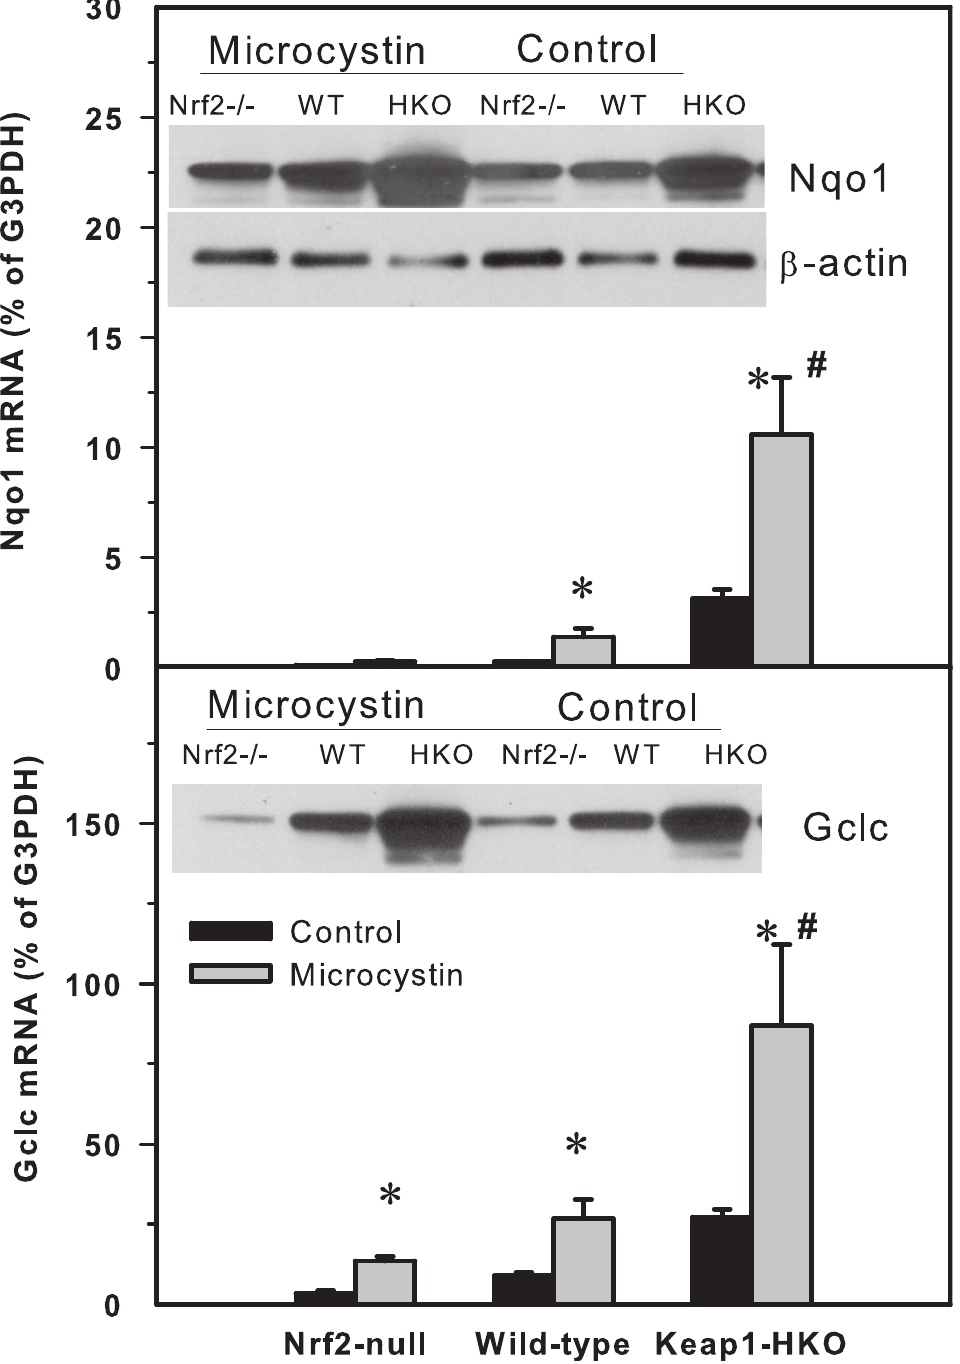
Figure 4. (Top) The mRNA levels of NAD(P)H quinone oxidoreductase 1 (Nqo1) and glutamate-cysteine ligase, catalytic subunit (Gclc) in Nrf2-null, wild-type and Keap1-HKO mice administered saline (10 ml/kg, i.p.) or microcystin (50 m g/kg, i.p.). Livers were removed 8 h after microcystin and mRNA quantified by RT-PCR. Values are expressed as mean 6 S.E.M. (n=8). *Significantly different from the basal level of the same genotype (p # 0.05); # Significantly different from Nrf2-null mice treated with microcystin (p # 0.05). Representative Western-blot analysis of Nqo1 and Gclc proteins inserted into mRNA expression graphs. Nqo1 and Gclc were higher in Keap1-HKO mice at both basal levels and after microcystin. doi:10.1371/journal.pone.0093013.g004 livers of the various groups of mice. Microcystin increased hepatic Gene Expression Analysis MDA levels 117% in Nrf2-null mice, 82% in WT mice, and 24% Nrf2-target genes Nqo1 and Gclc. To determine the in the Keap1-HKO mice. mechanism of how Nrf2 protects against microcystin-induced